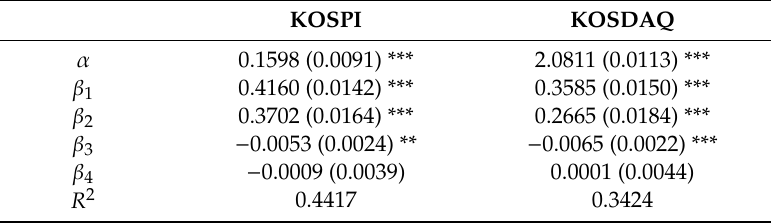
Table 3. Estimates of herding behavior in up- and down-market